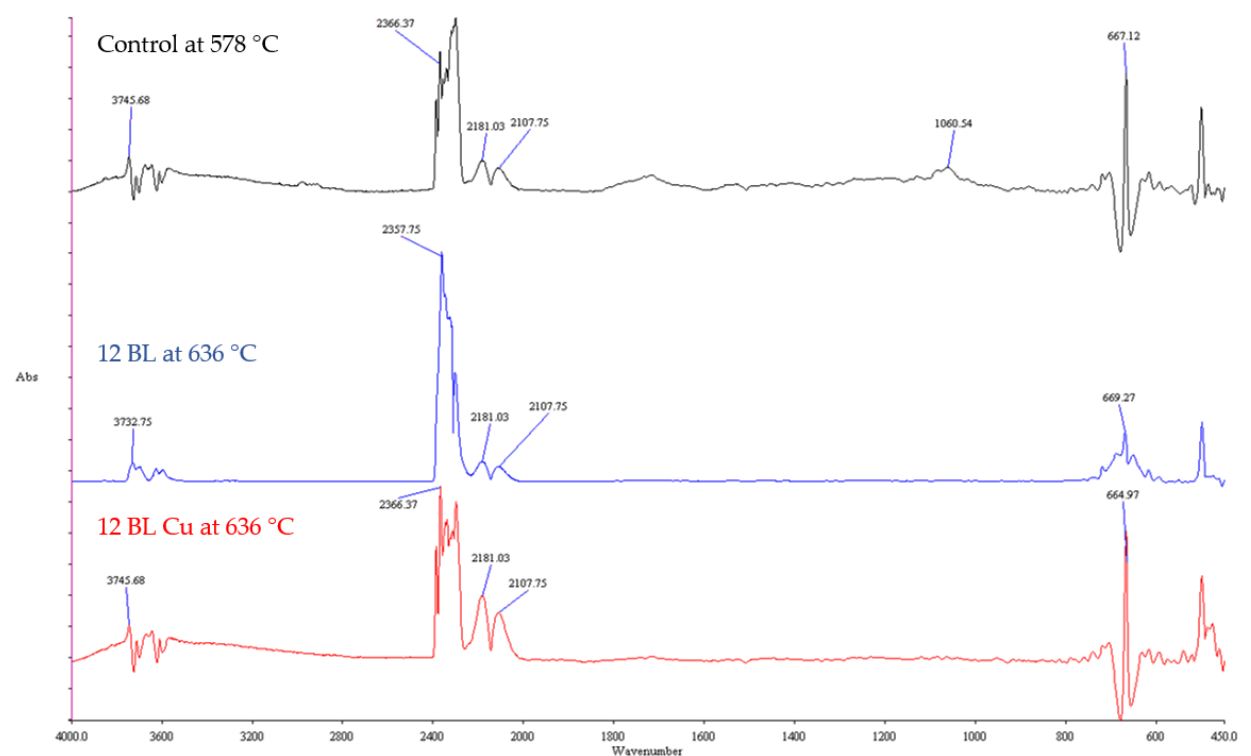
Figure 6. IR spectra of untreated and 12 BL-treated cotton at the second decomposition stage (T 2 ).